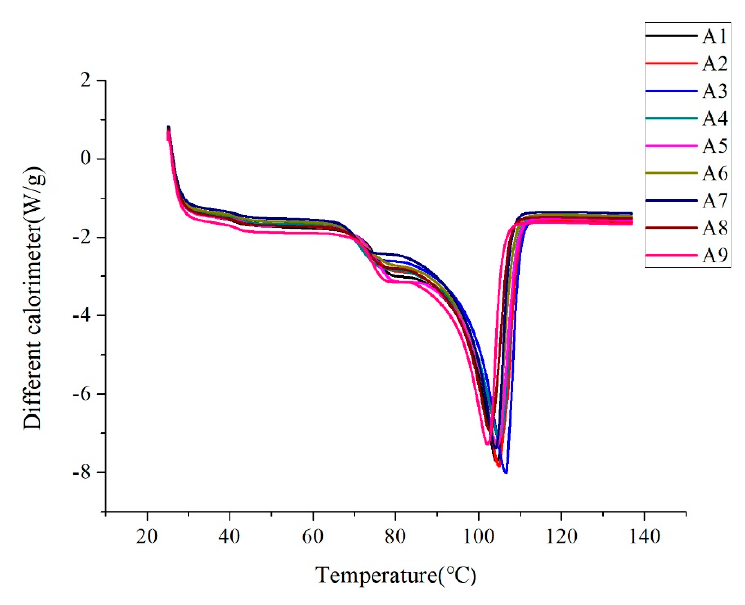
Figure 2. Test results of differential scanning calorimetry (DSC) test.